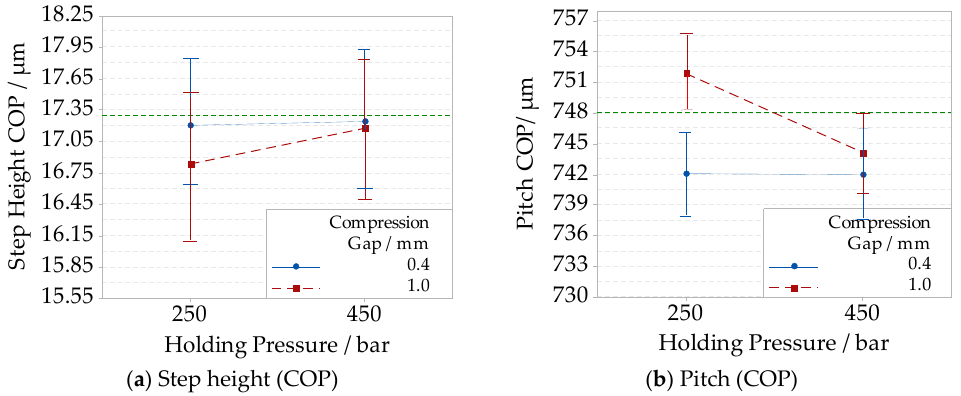
Figure 9. Interaction plots showing the replication of absolute dimensions of the Fresnel lens’ groove